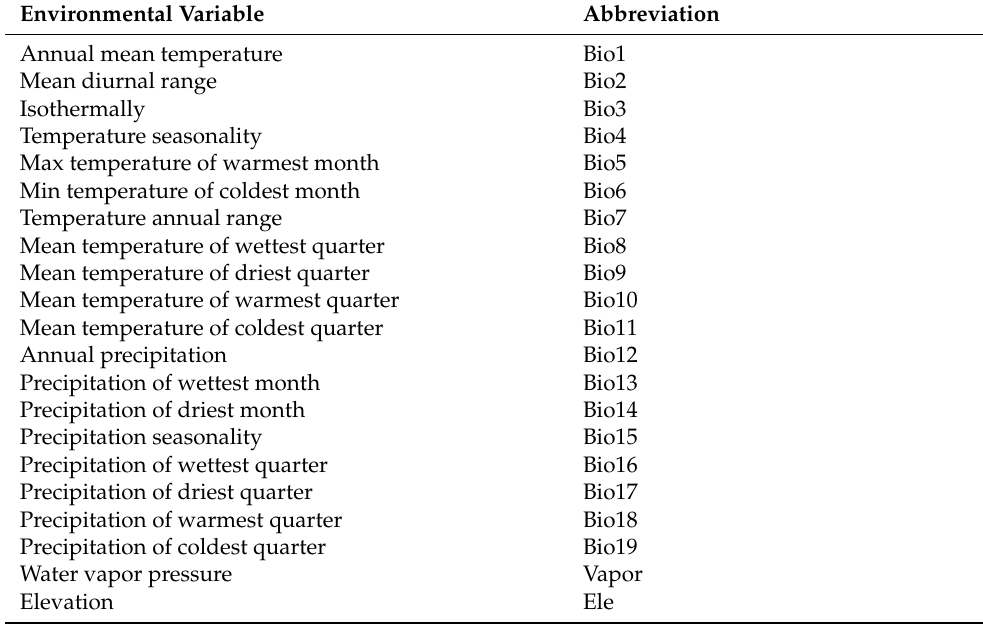
Table 1. Related environmental